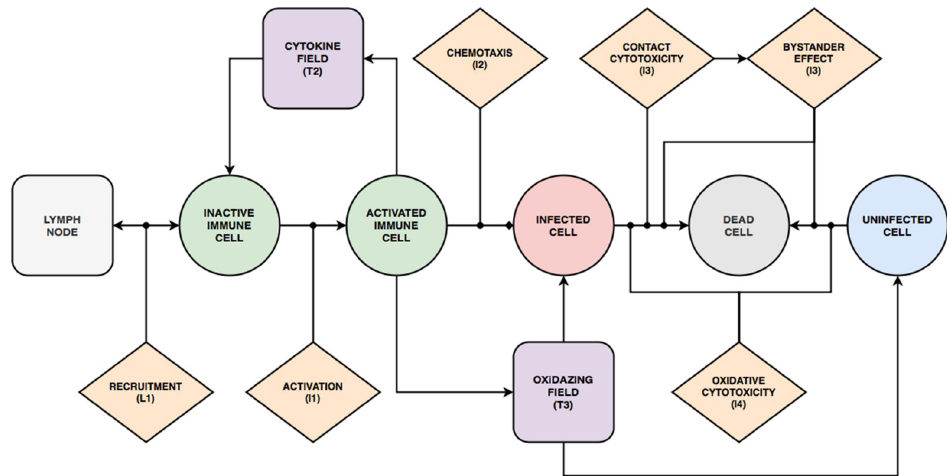
Fig 17. State diagram and interactions of Immune cells. Immune cells can adopt two different generalized types: inactive and activated. Inactive immune cells are recruited by the cytokine levels according to the immune recruitment module ( L1 ).Transition from inactive to activated immune cells is determined by the immune activation module ( I1 ) when cells are exposed to cytokines in the tissue. Activated immune cells amplify the cytokine signal by secreting cytokines to the extracellular environment. Activated immune cells chemotax towards virus-releasing cells ( I2 ). Immune cells induce death of epithelial cells by direct cytotoxicity when coming into contact with infected cells ( I3 ), bystander effect by killing neighbors of infected cells ( I3 ) and through oxidative cytotoxicity ( I4 ) by releasing cytotoxic oxidizing agents ( T3 ) into the extracellular environment. bound cytokine each time step while taking up an amount of cytokine from the environment ( ω ( τ ( σ ), t ) defined in T2 ), cyt